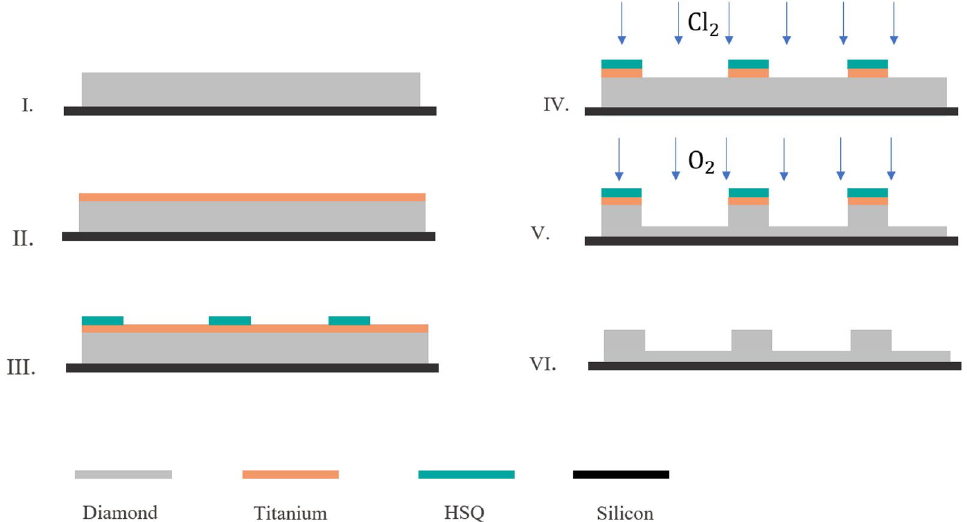
Figure 7. Fabrication process for large-scale diamond nanopillar arrays. ( I ) The single-crystal diamond substrate is cleaned, polished (see main text) and die-attached on a Si carrier wafer. ( II ) Sputtering of Ti hard mask (200 nm). ( III ) Spin-coating of HSQ negative resist (150 nm), electron beam lithography for pillars, and development in TMAH. ( IV ) Cl 2 -based reactive ion etching patterning of the Ti layer. ( V ) Highly directional O 2 -plasma etch of diamond substrate. ( VI ) Stripping of the hard mask in diluted hydrofluoric acid